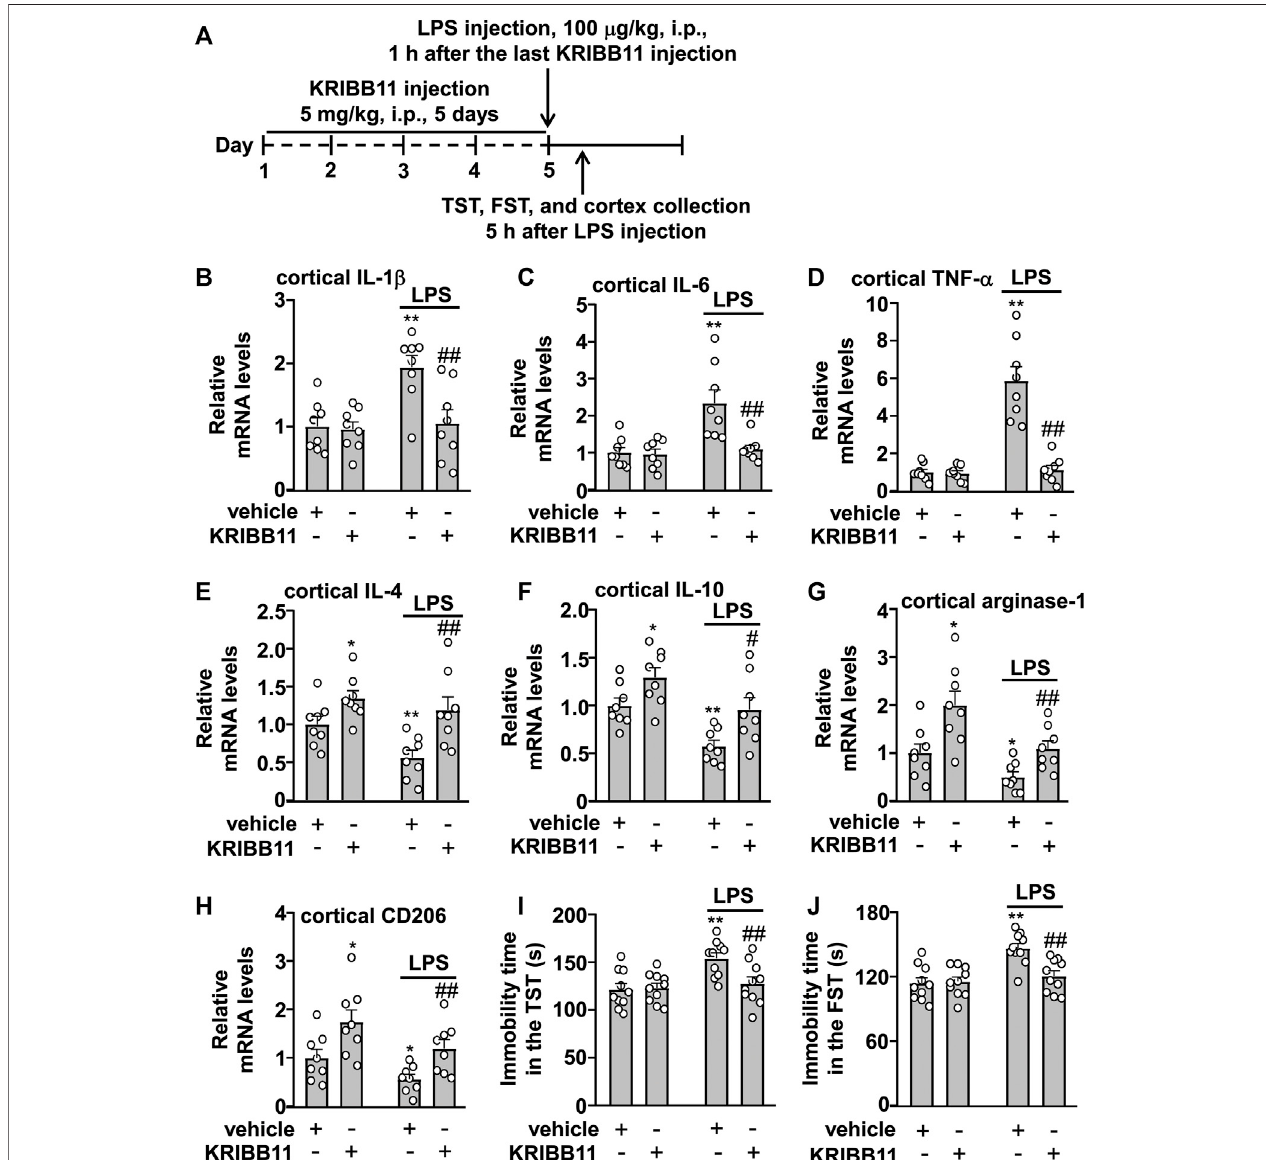
FIGURE 5 | Effects of KRIBB11 on LPS-induced in fl ammatory responses in the dorsolateral prefrontal cortex and depression-like behaviors in mice. (A) Time-line showing the investigation of the effects of KRIBB11 on LPS-induced in fl ammatory responses in the dorsolateral prefrontal cortex and depression-like behaviors. (B ‒ D) Quantitative analysisshowed the preventive effect ofKRIBB11 pretreatment (5 mg/kg, 5 days)on LPS (100 μ g/kg, 5 h)-induced increases in theexpression levels ofIL- 1 β (B) , IL-6 (C) , and TNF- α (D) mRNA in the dorsolateral prefrontal cortex ( n = 8, ** p < 0.01 vs. vehicle, ## p < 0.01 vs. vehicle + LPS). (E ‒ H) Quantitative analysis showed the effect of KRIBB11 pretreatment (5 mg/kg, 5 days) on the expression levels of IL-4 (E) , IL-10 (F) , arginase-1 (G) , and CD206 (H) mRNA in the dorsolateral prefrontalcortexinmicetreatedwithorwithoutLPS(100 μ g/kg,5 h; n =8,* p < 0.05or** p < 0.01vs.vehicle,# p < 0.05or## p < 0.01vs.vehicle+LPS). (I,J) Quantitative analysis showed the preventive effect of KRIBB11 pretreatment (5 mg/kg, 5 days) on LPS (100 μ g/kg, 5 h)-induced increases in the immobility time in the TST (I) and FST (J) in mice ( n = 10, ** p < 0.01 vs. vehicle, ## p < 0.01 vs. vehicle + LPS). Data are shown as mean ± SEM.